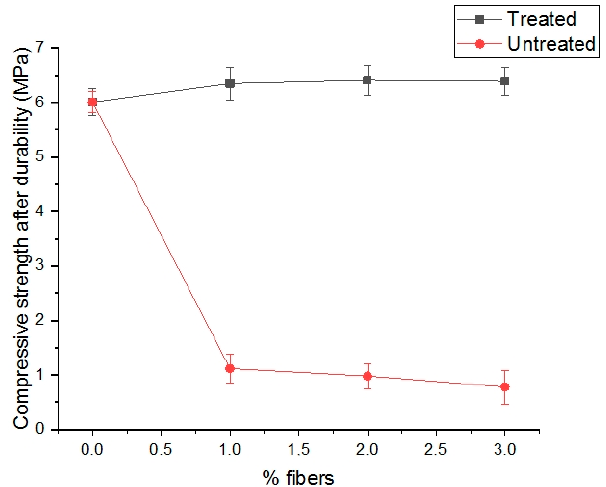
Figure 5. Compressive strength after durability test of mortar.